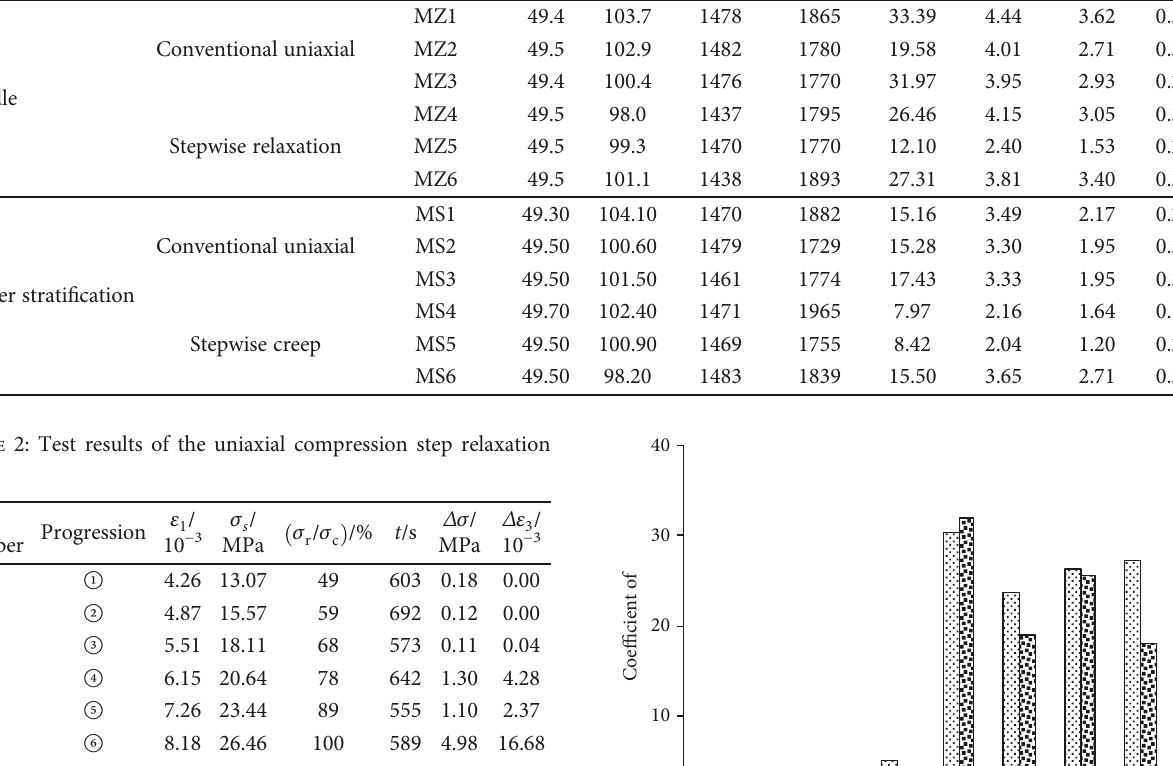
Table 1: Test results for coal samples subjected to uniaxial compression and step relaxation. Position